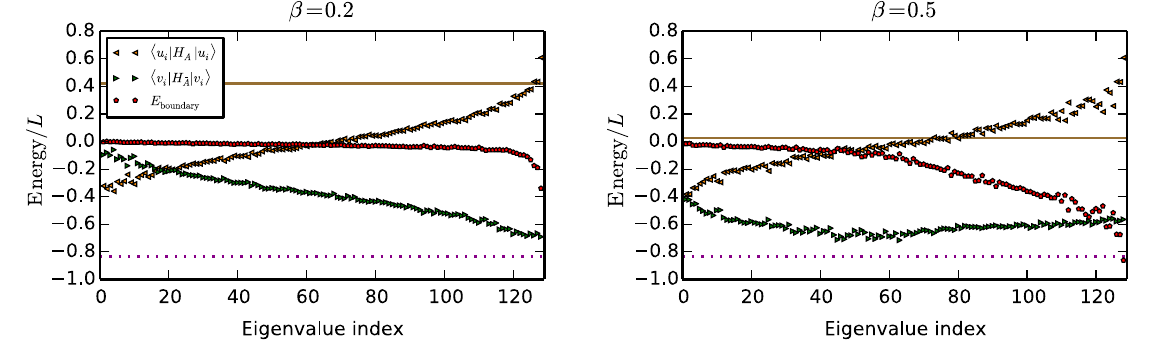
FIG. 14. Decomposition of the energy density corresponding to an eigenstate amongst the three terms in Eq. (17) for β ¼ 0 . 2 (left panel) and β ¼ 0 . 5 (right panel) at L ¼ 21 and L brown line denotes the critical energy density e (cid:3) for subsystem A .